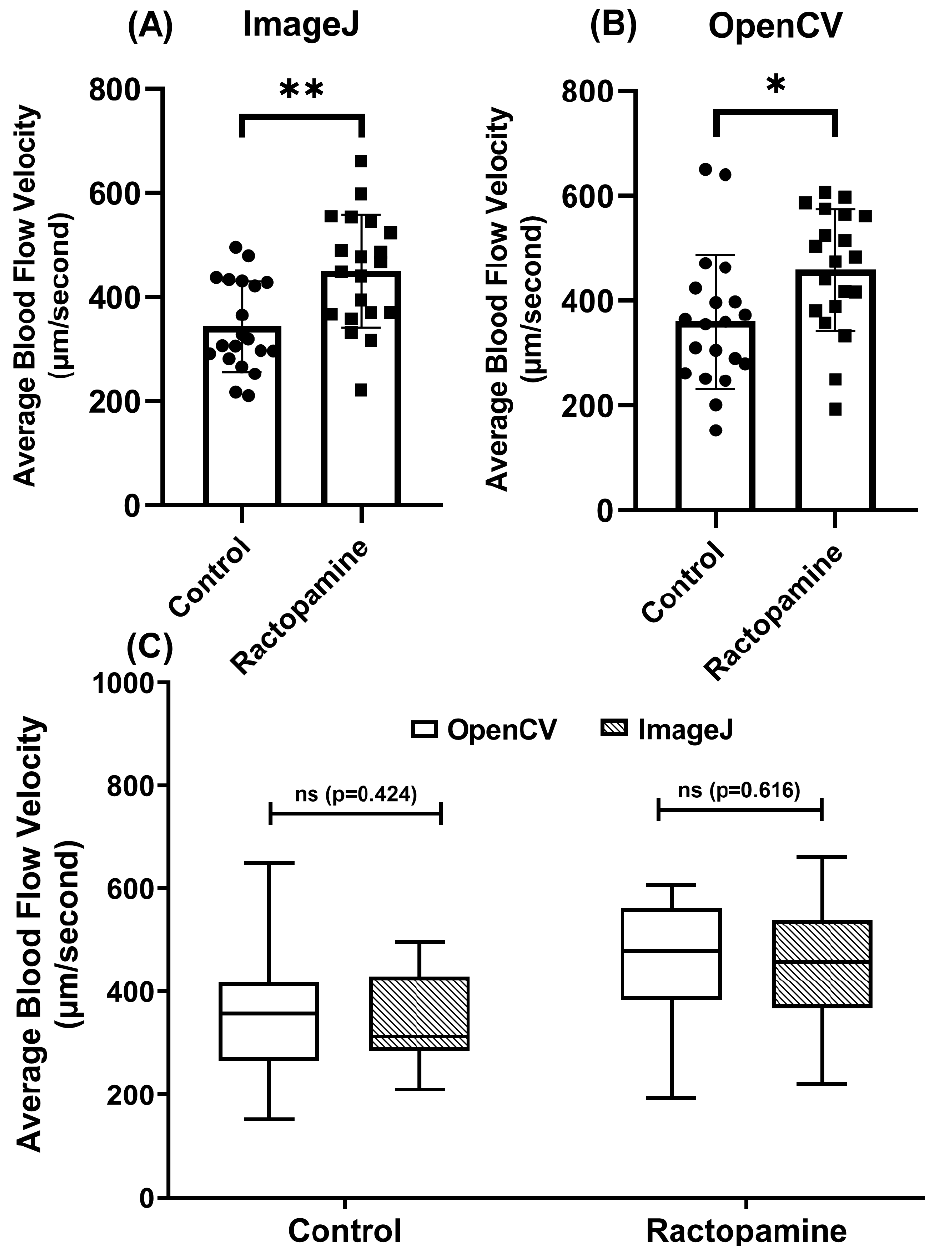
Figure 6. Validation of OpenBloodFlow performance for blood flow velocity measurement in zebrafish larvae through comparison with ImageJ method. Average blood flow velocity measured by ImageJ ( A ) and OpenBloodFlow ( B ) after exposure to ractopamine. Ractopamine exposure significantly elevated the average blood flow in zebrafish. ( C ) Side-by-side comparison of the average blood flow velocity measurement by ImageJ or OpenCV methods. The data were shown as mean with standard deviation and statistical significance determined by paired t -test for intra-group comparison (ns = no significance, * p < 0.05, ** p < 0.01, n = 20) (circle dots show the control data, while square dots show the ractopamine data in A and B).